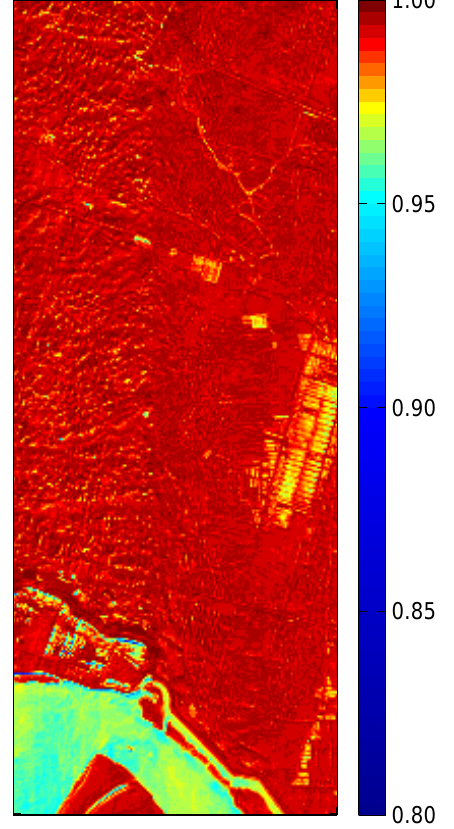
Figure 6 . Cosine values of vector angles between simulated and original data of each